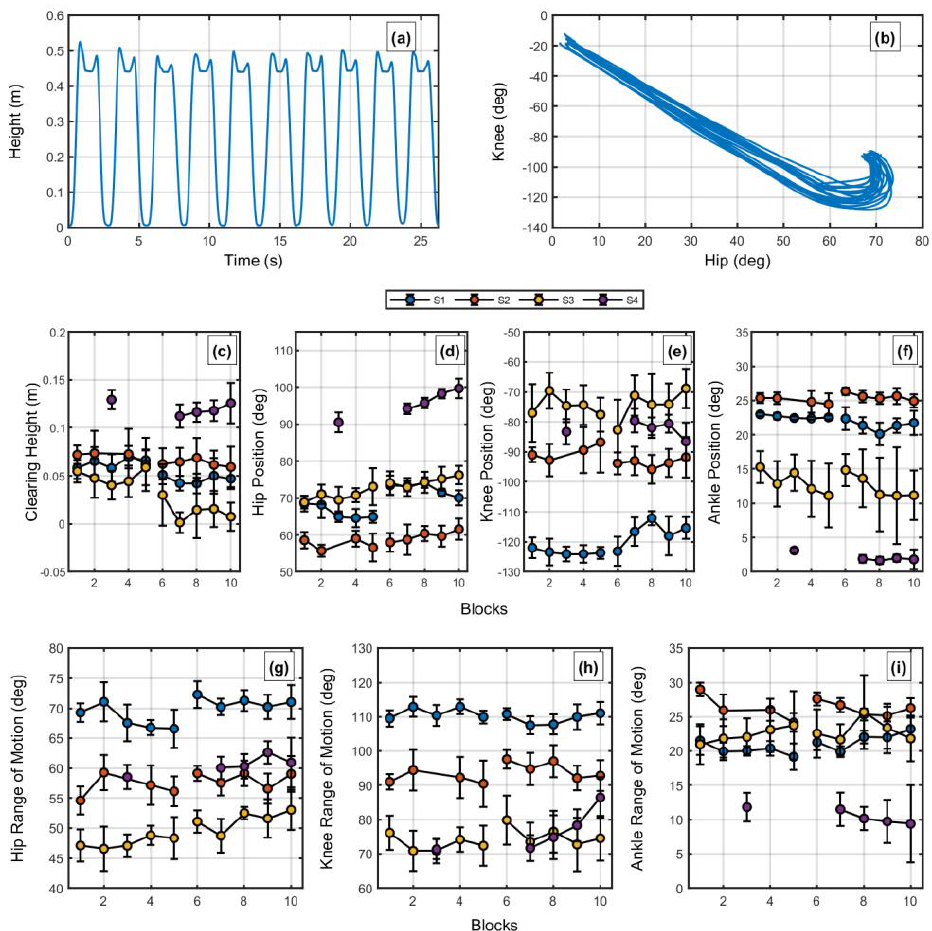
Figure 1. ( a ) Foot height over ten stepping movements in the task of an exemplary participant. ( b ) Angle-angle plot of the same exemplary participant for knee and hip flexion over ten stepping movements. ( c ) Average clearing height (peak foot height minus the step height) of all participants per block (ten movements) and step height. ( d ) Average hip position (flexion) at peak foot height of all participants per block (ten movements) and step height. ( e ) Average knee position (flexion) at peak foot height of all participants per block (ten movements) and step height. ( f ) Average ankle position (flexion) at peak foot height of all participants per block (ten movements) and step height. ( g ) Average hip range of motion of all participants per block (ten movements) and step height. ( h ) Average knee range of motion of all participants per block (ten movements) and step height. ( i ) Average ankle range of motion of all participants per block (ten movements) and step height.